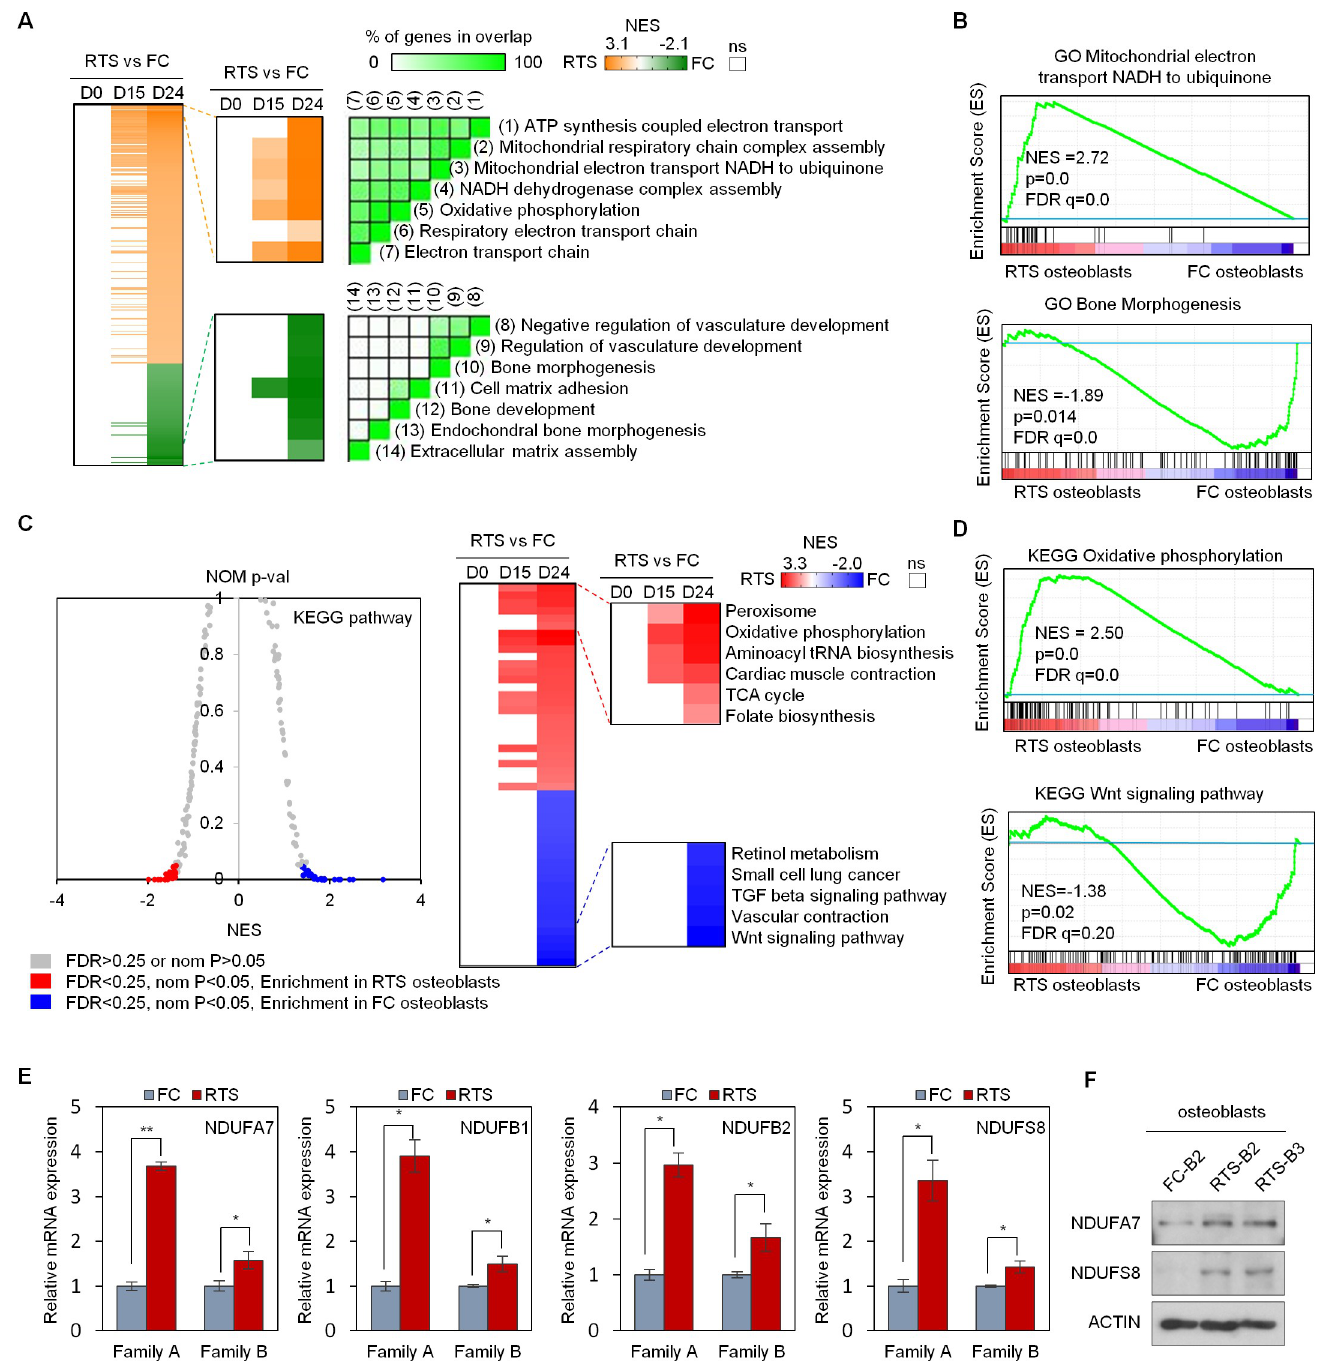
Fig 3. Transcriptional analysis reveals increased OXPHOS in RTS osteoblasts. (A) GSEA analyses identify gene ontology biological processes (GO_BP) from a collection of 7525 genes sets (left) enriched in RTS or FC osteoblasts. GO_BP gene sets enriched (orange, corresponding to a positive normalized enrichment score (NES)) or depleted (green, corresponding to a negative NES) in the transcriptome of RTS compared to FC osteoblasts are shown. Enriched gene sets are selected based on statistical significance (normalized p-value < 0.05 and FDR q-value < 0.25). Middle, heatmap of significantly altered GO_BPs in RTS MSCs (D0), pre- osteoblasts (D15), and osteoblasts (D24) compared to FC counterparts. Right, GSEA leading edge analysis demonstrates the overlap between gene sets enriched in RTS and FC osteoblasts. (B) GSEA GO_BP results for mitochondrial electron transfer NADH to ubiquinone and bone morphogenesis. (C) KEGG pathway analyses identify enriched pathways in RTS and FC osteoblasts. Left, 183 total pathways are included in KEGG pathway analysis. Pathways enriched in the transcriptome of FC osteoblasts have a negative normalized enrichment score (NES) (blue), while pathways with a positive NES (shown in red) are enriched in the transcriptome of RTS osteoblasts. Enriched pathways are selected based on statistical significance (normalized p-value < 0.05 and FDR q-value < 0.25). Right, heatmap showing